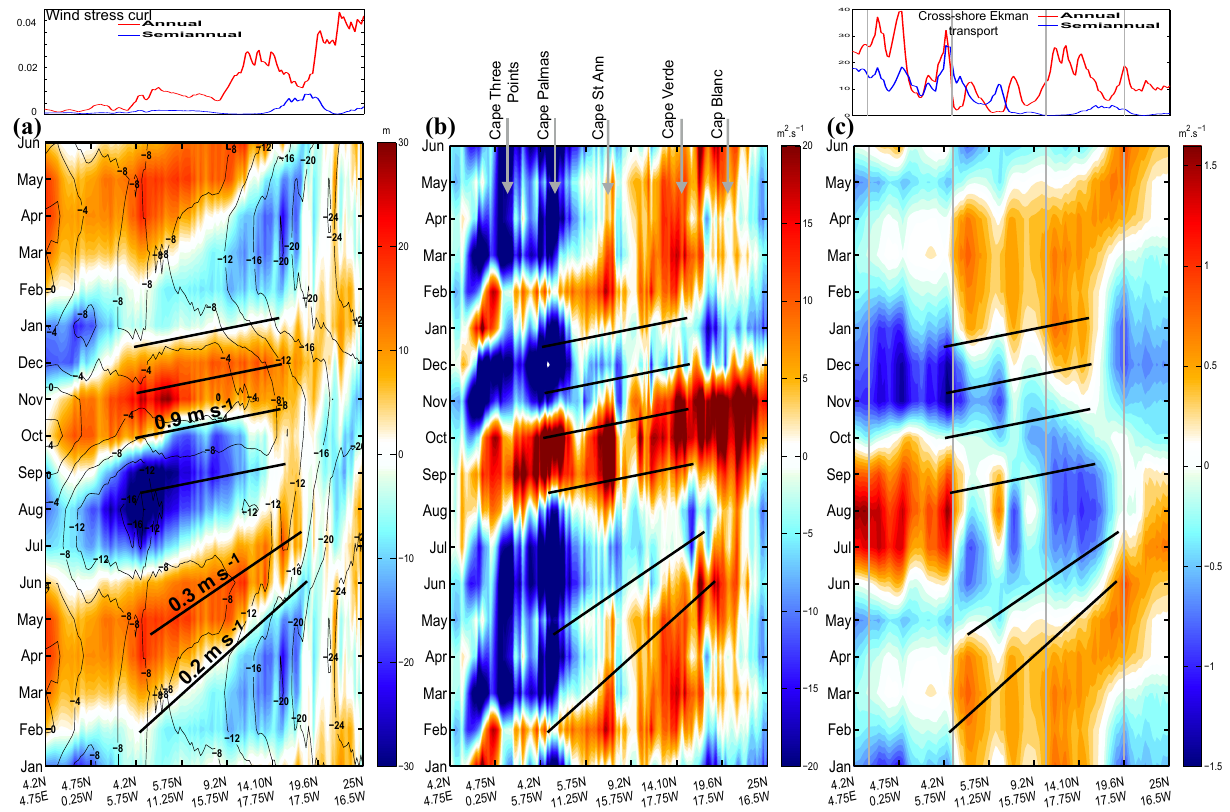
Figure 12. Time–along-slope distance diagram following the 100m isobath (see location in Fig. 1) for the TROP025 climatological seasonal cycle of (a) the depth anomaly of the 18 ◦ isotherm δz 18 (colors; in meters) and SLA (contours; cm), (b) along-slope geostrophic transport between σ t = 26 . 7 and the surface V 26 . 7 g (m 2 s − 1 ), and (c) across-shore Ekman transport anomaly. Oblique solid black lines correspond to propagation speeds of 0.2–0.3 (February–June) and 0.9ms − 1 (August–January). They are subjectively drawn in (a) (and repeated in b and c ) to indicate where spatiotemporal patterns are suggestive of along-slope propagation. In panel (c) , vertical gray lines delineate the sectors over which sector upwelling indices are computed (see Fig. 13). Power spectral densities associated with the annual and semiannual harmonics of the wind stress curl and cross-shore Ekman transport along the 100m isobath are displayed above (a) and (c) ,